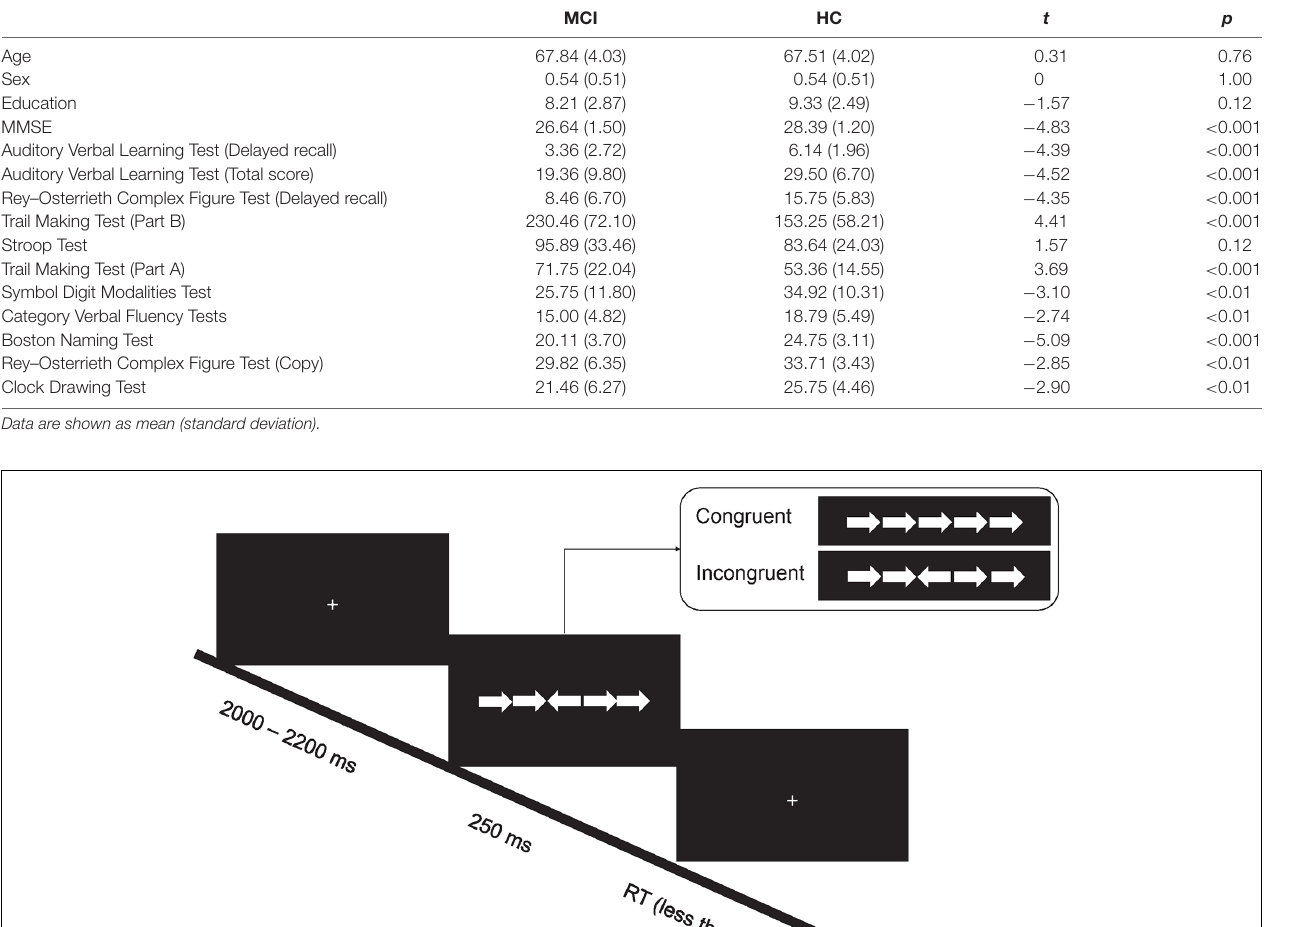
TABLE 1 | The demographic information and the performance on neuropsychological tests in older adults with mild cognitive impairment (MCI) and healthy controls (HCs).